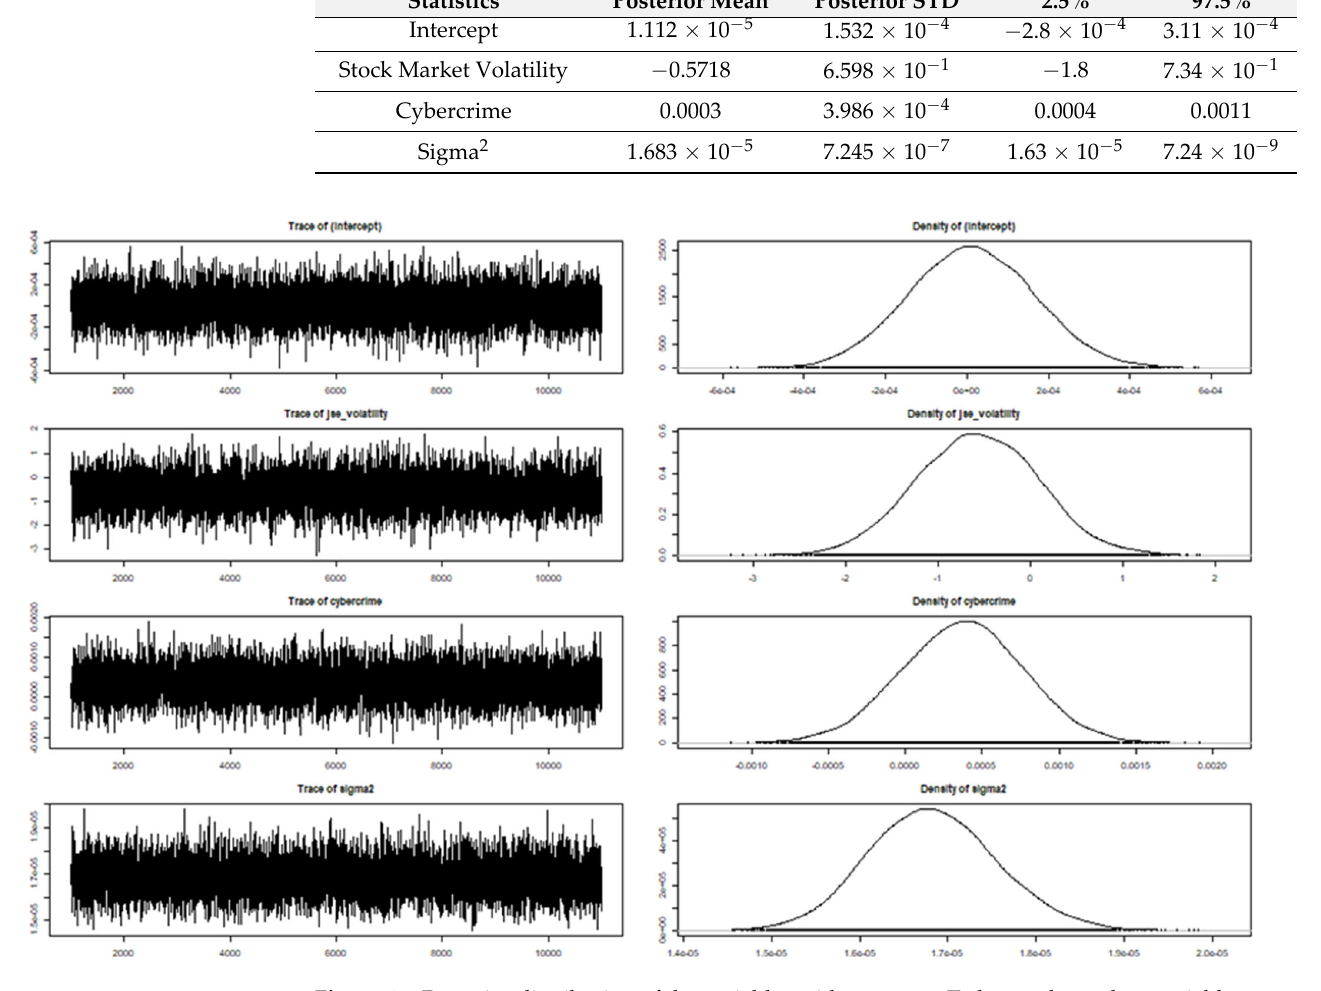
Figure 10. From Table 5, it is observed that stock market volatility has negative effects on returns of Tether while cybercrime is found to have an insignificant positive impact on the returns of Tether during the period under consideration in the South African economy.